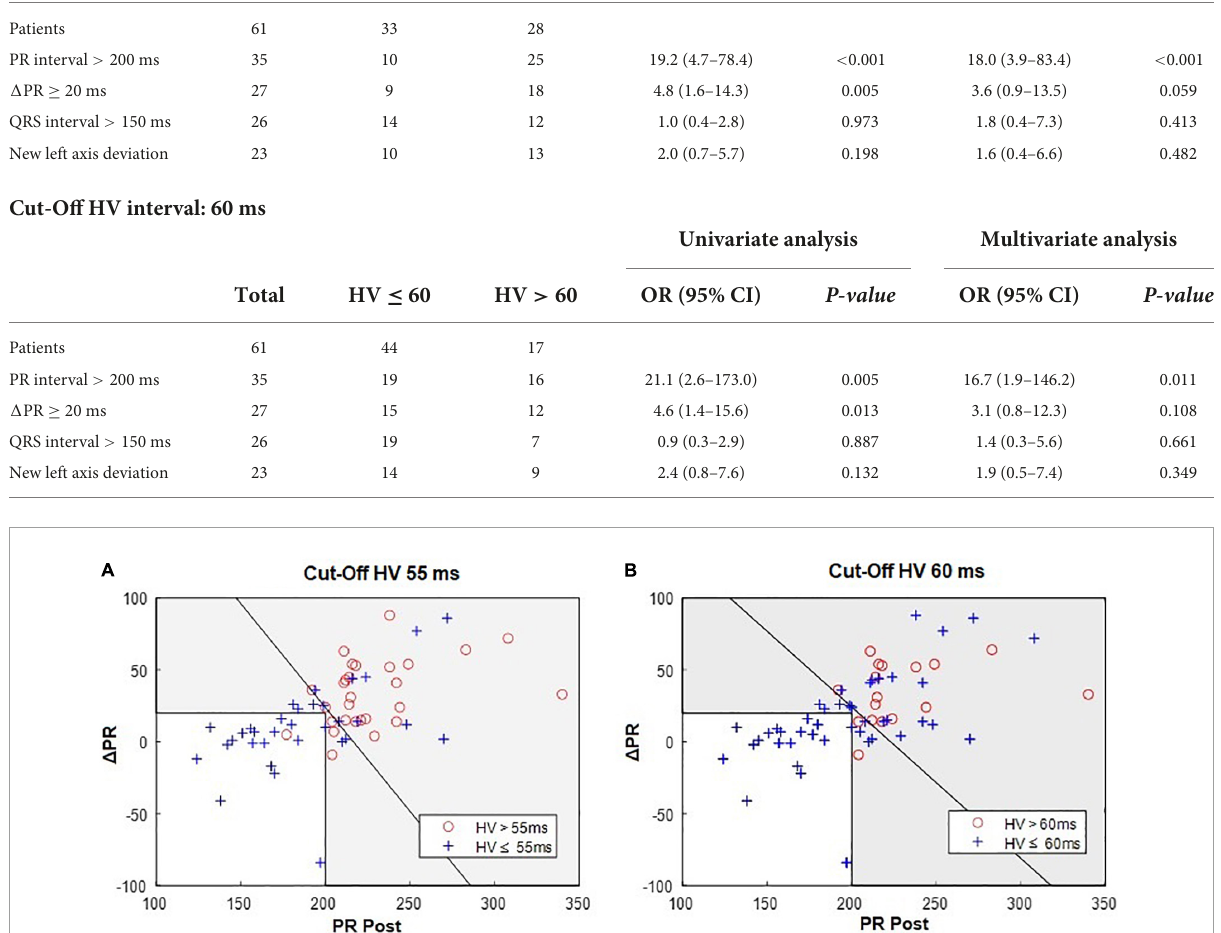
FIGURE2 Bivariate analysis of the PR and (cid:49) PR intervals: 96% (27/28) of patients with an HV > 55 ms (A) have PR > 200 ms OR (cid:49) PR ≥ 20 ms; (B) 100% (17/17) of patients with an HV > 60 ms have PR > 200 ms OR (cid:49) PR ≥ 20 ms. In each graph, the oblique line indicates the optimal separation between normal and abnormal HV intervals. Gray area represents the acceptance zone for the parallel testing, i.e., PR post > 200 ms OR (cid:49) PR ≥ 20